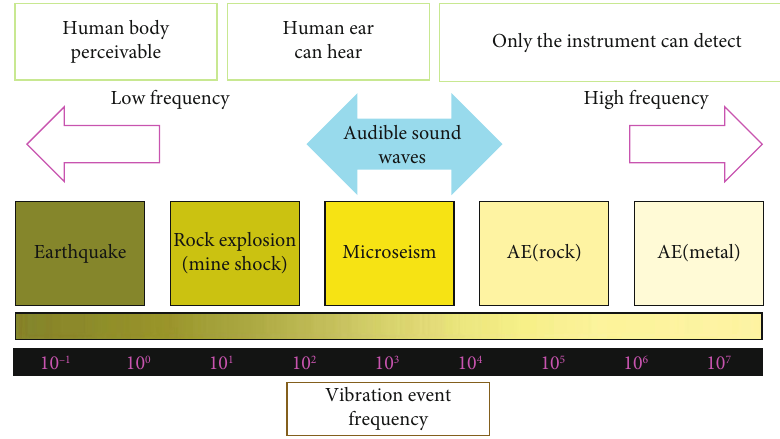
Figure 6: Vibration event frequency.